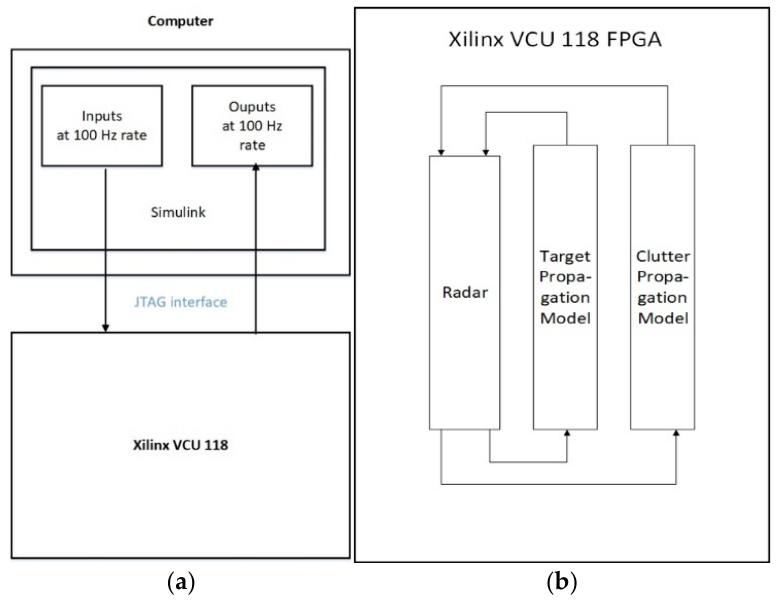
Figure 8. ( a ) The field programmable gate array (FPGA)-in-the-loop block diagram. JTAG stands for the joint test action group. ( b ) the zoom-in plot of the Xilinx VCU 118 FPGA block in ( a ), where a high-level block diagram of the implementation is shown.